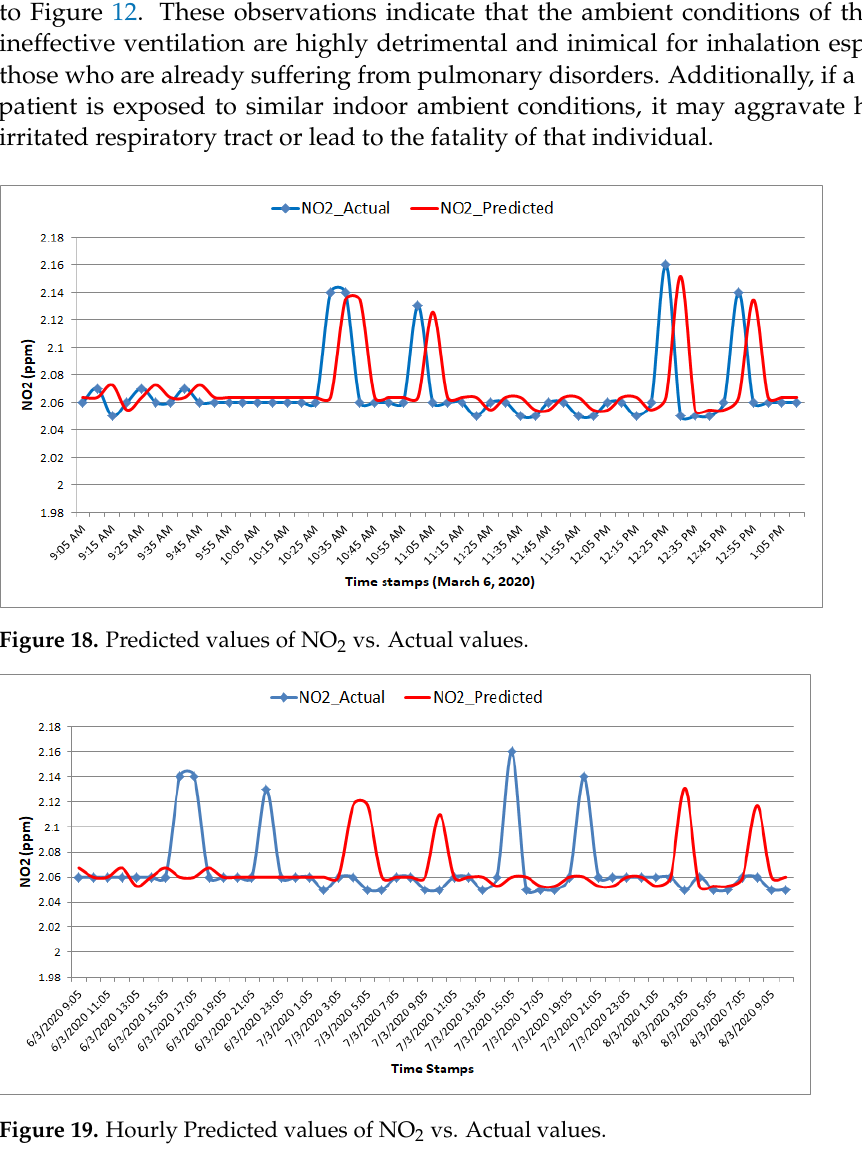
Figure 19. Hourly Predicted values of NO 2 vs. Actual